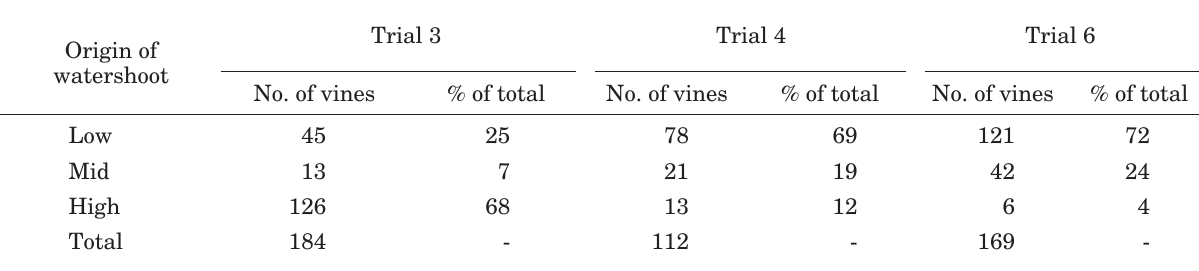
Table 3. Watershoot production on ‘Shiraz’ vines cut high during remedial surgery in Trials 3 and 4 (Coonawarra, South Australia) and Trial 6 (Eden Valley, South Australia), showing the number of vines from which the lowest available shoots arose from either low (bottom third), mid (middle third) or high (top third) positions on the trunk and the percentage of vines in each category.